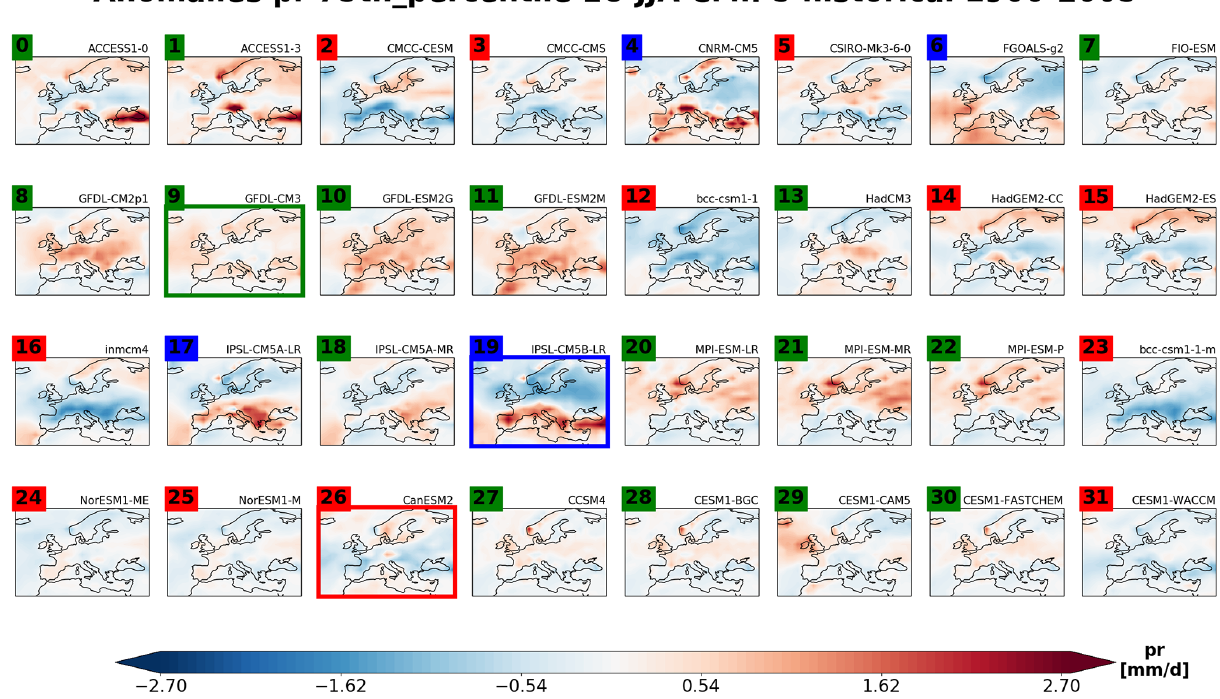
Figure 18. Clustering based on the 75th percentile of the historical summer (JJA) daily precipitation rate for 32 CMIP5 models for the period 1900–2005. The colour of the model number of each ensemble member indicates the cluster to which they belong. The most representative members of each cluster are marked with a coloured border. See Sect. 3.5 for details on recipe_ensclus.yml